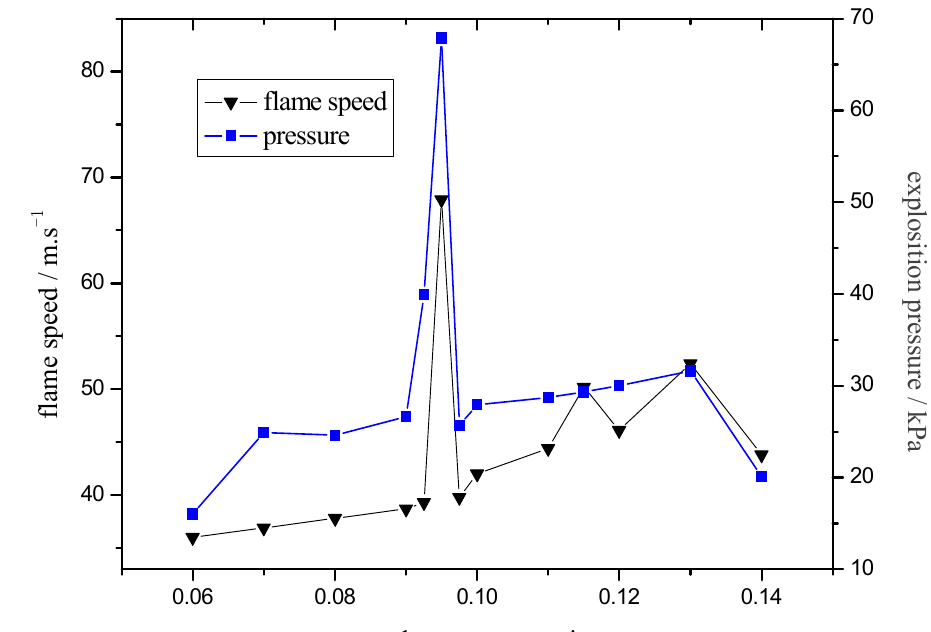
Figure 4. Explosion pressure and flame speed in the laminar